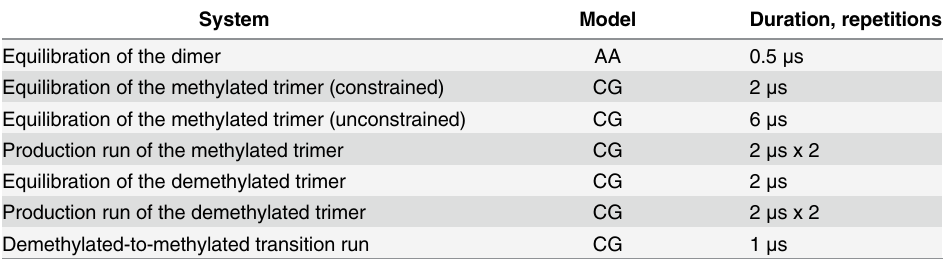
Table 1. List of simulations performed. System Model Duration, repetitions Equilibration of the dimer AA Equilibration of the methylated trimer (constrained) Equilibration of the methylated trimer (unconstrained) Production run of the methylated